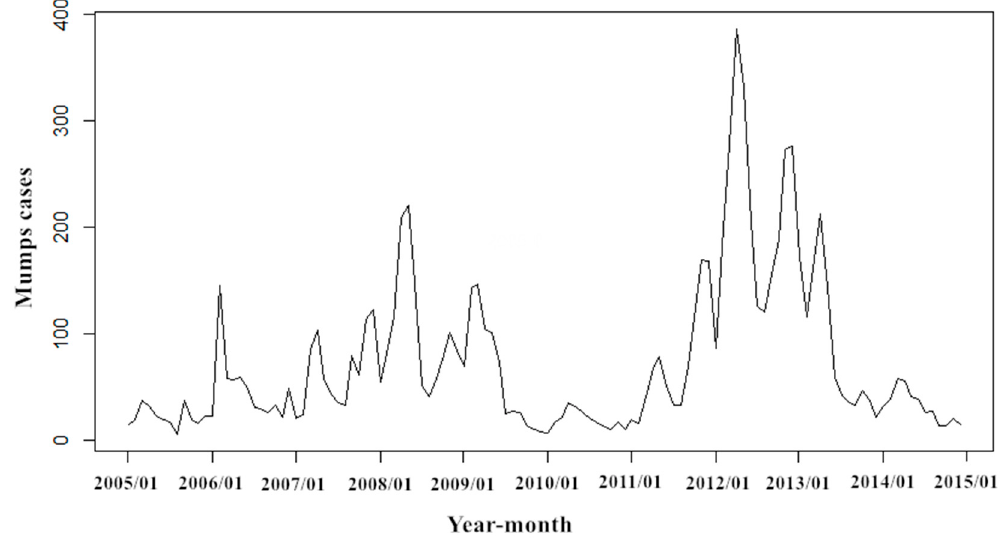
Figure 4. Sequence diagram of monthly mumps cases from January 2005 to December 2014 in Zibo City.